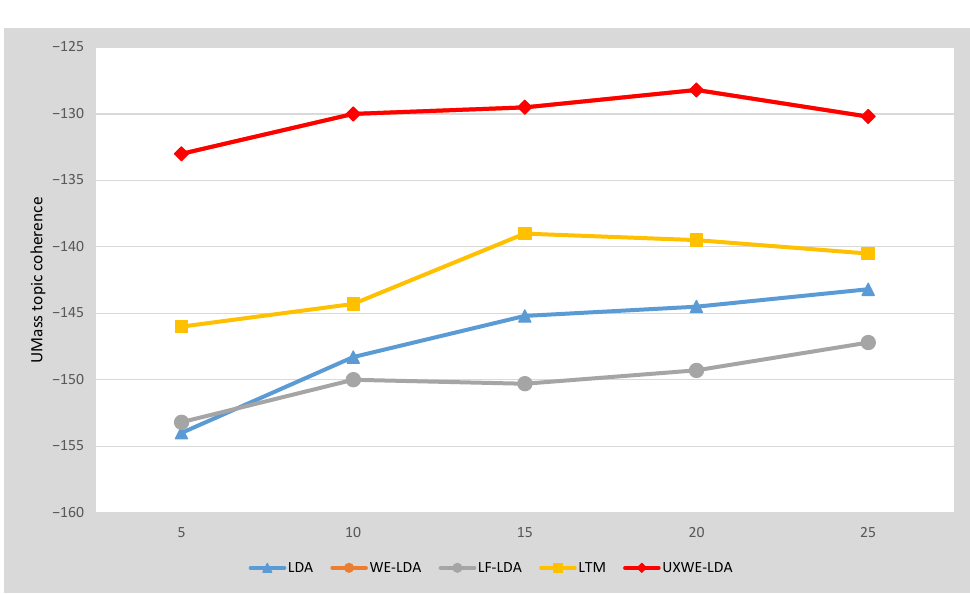
Figure 11. Average TC of top words with different number of topics on on both